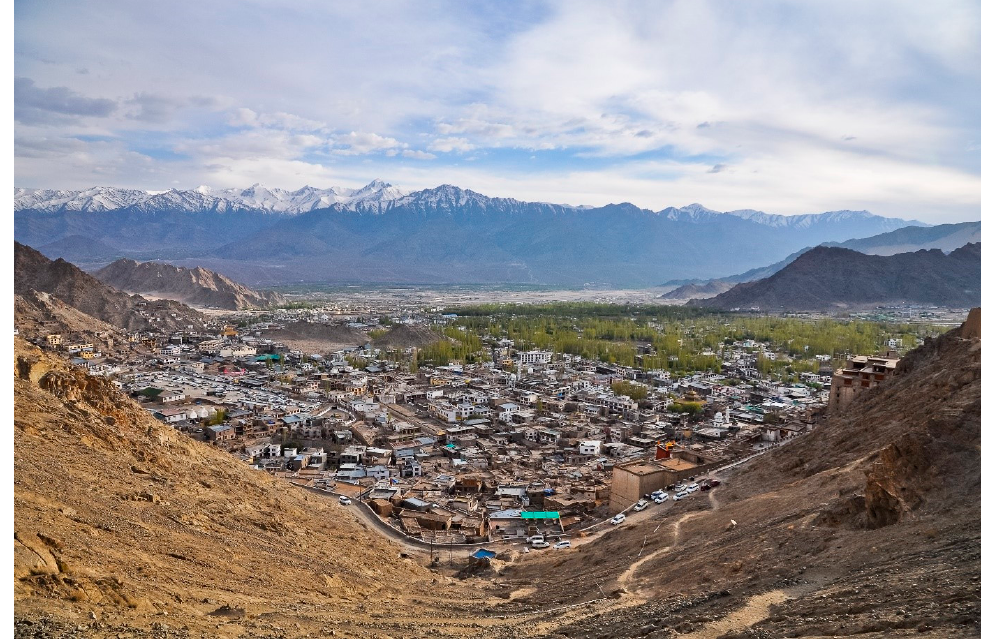
Figure 1. View of Leh town in southwest direction, with Old Town in the foreground (photo taken by Judith Müller, 2016).